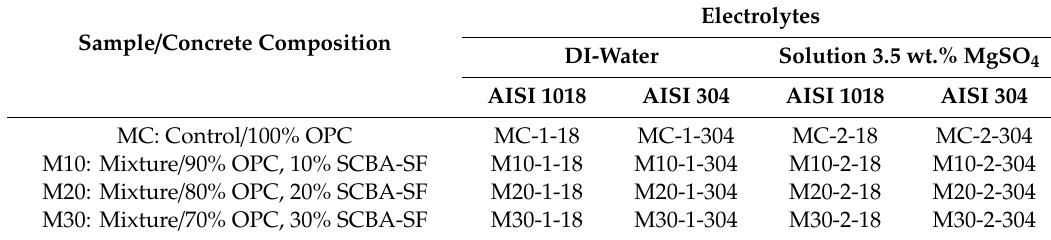
Table 6. Nomenclature of specimens tested for a period of 180